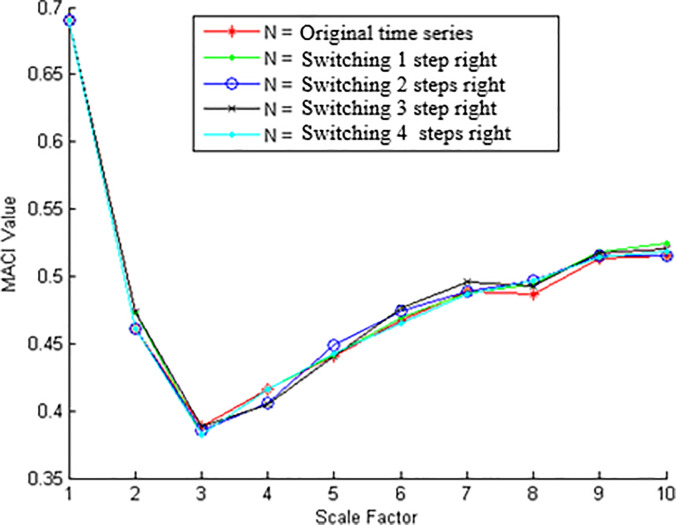
Switching of averaging brackets to the right.